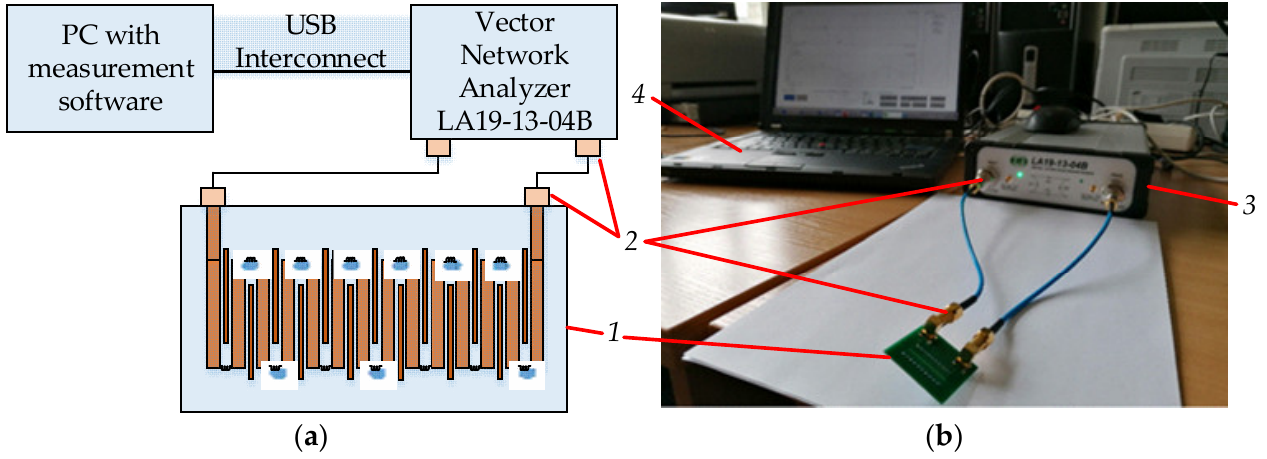
Figure 4. ( a ) A block diagram of an experimental measurement of the hybrid meander structure and ( b ) a general photo- graph of the experiment, where 1 is the hybrid meander structure with additional shields, 2 are SMA connections, 3 is a vector network analyzer, and 4 is a computer with the measurement software.